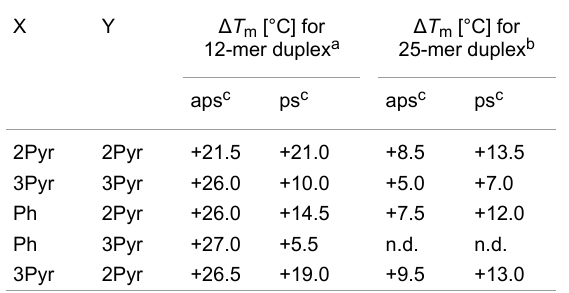
Table 2: Increase in melting temperature Δ T m of two sets of DNA duplexes bearing a X PC–Ag(I) 2 – Y PC base pair (X, Y = phenyl, 2-pyridyl, 3-pyridyl) [62].